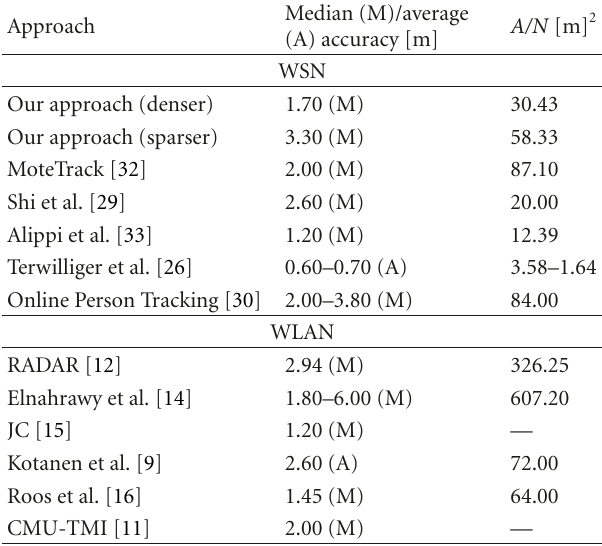
Table 6: Location estimation accuracy comparison. The anchor node density is expressed by A/N , where A denotes size of the test area and N denotes the anchor node amount used in the